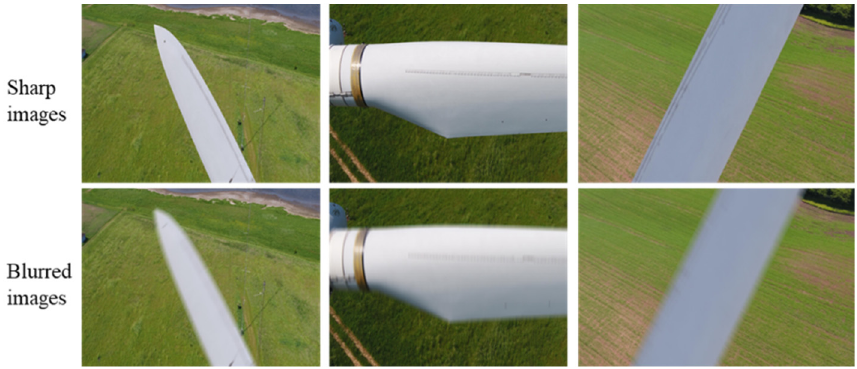
Figure 8. Three example images from dataset #3.3. Hybrid Motion Deblurring